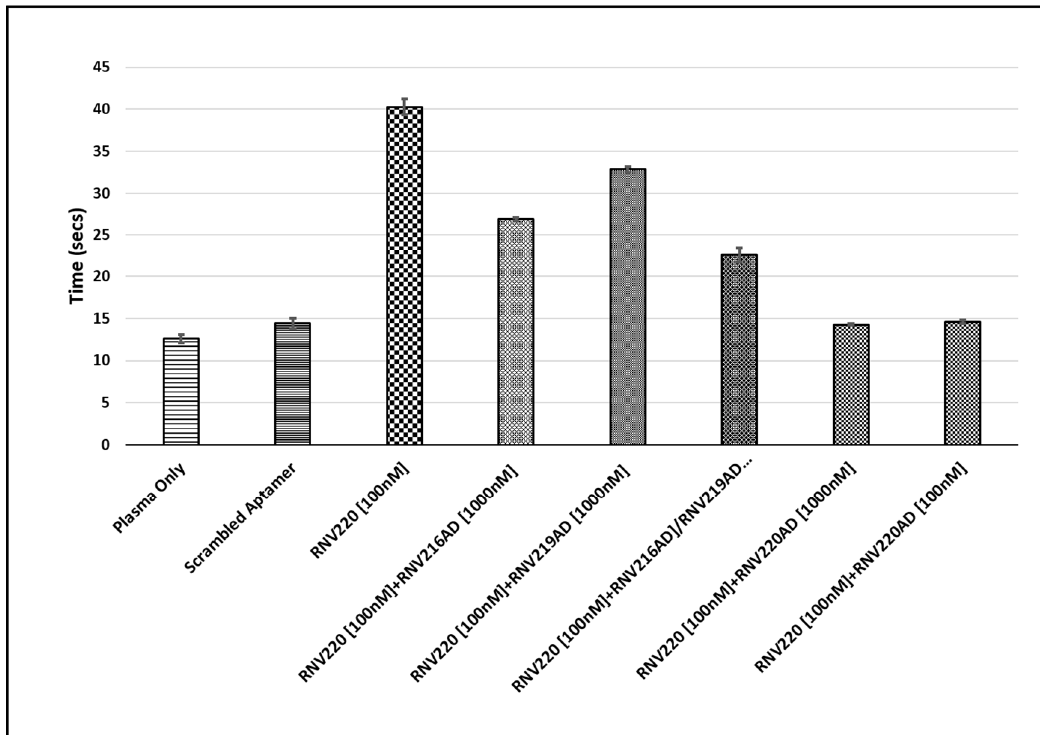
Figure 3. TCT analysis of the antidote sequences RNV216AD, RNV219AD, and RNV220AD to the aptamer RNV220.